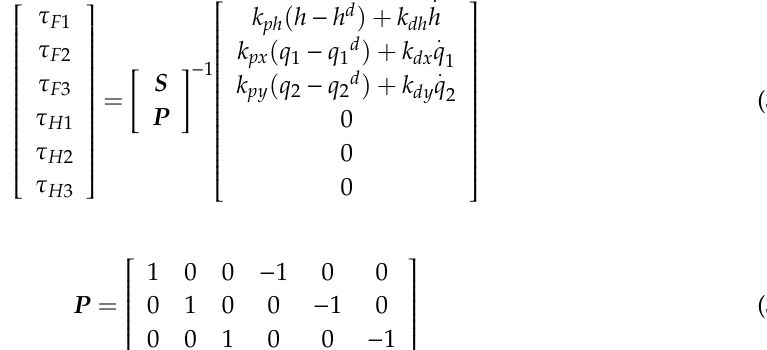
Figure 15. The pitching knee joint position tracking curves of RF leg of the robot. ( a ) Response curves; ( b ) Local amplification curves.